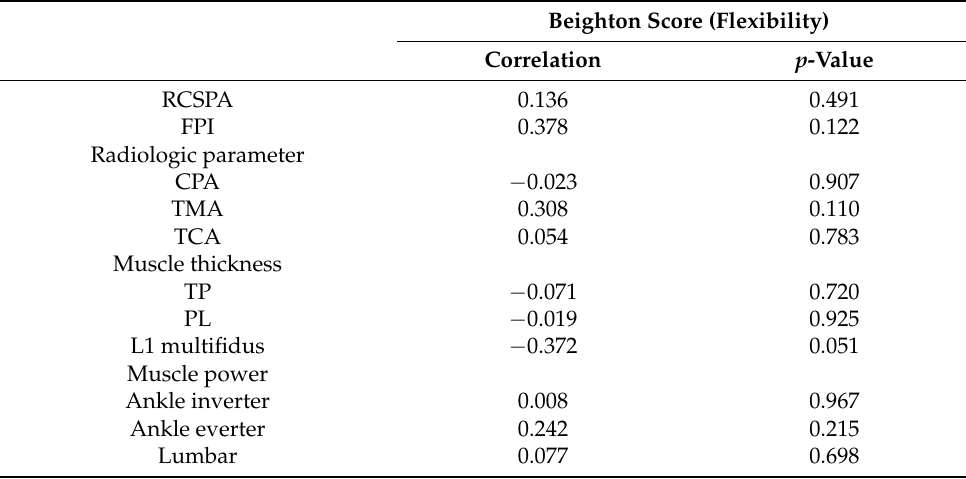
Table 8. Correlation between Beighton score and RCSP, FPI, radiologic parameters, muscle thickness, and muscle power of flatfoot for all participants (n =